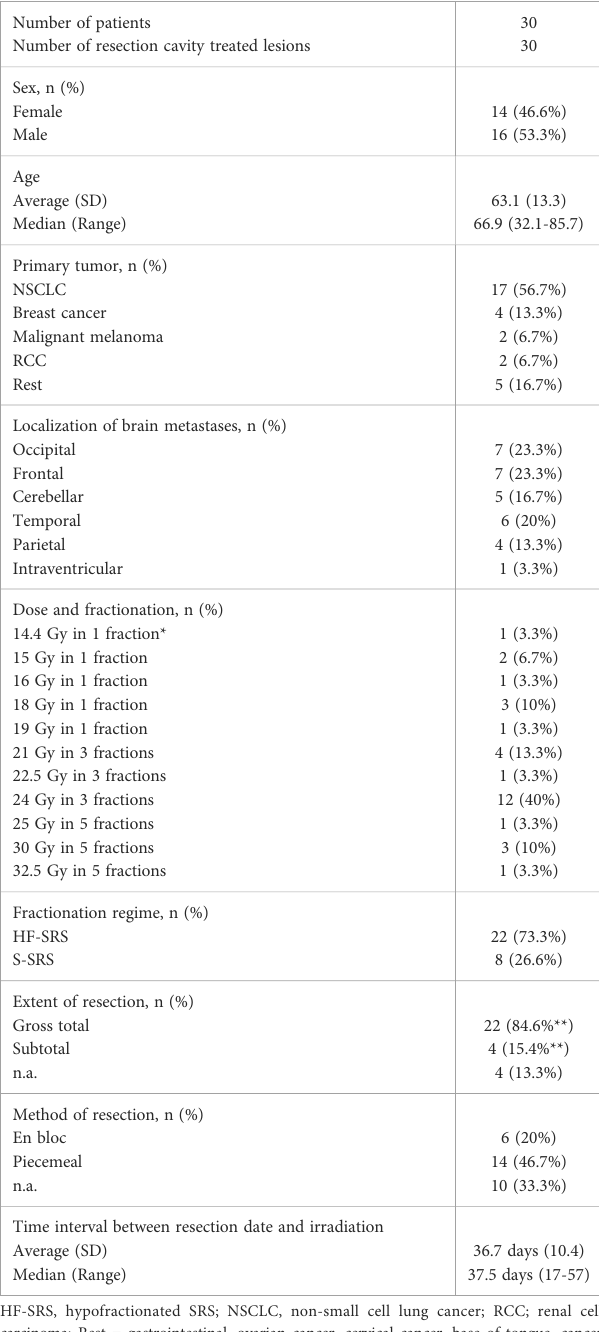
TABLE 3 Patient, tumor and treatment